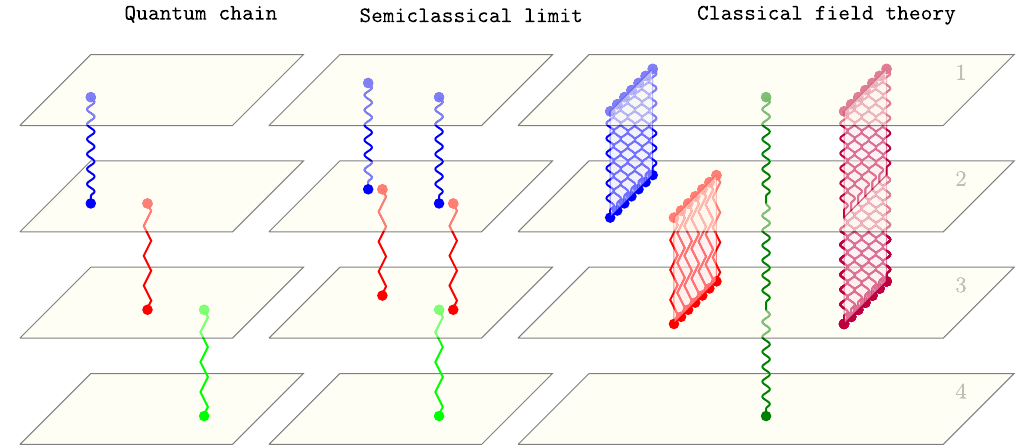
4. Elementary and auxiliary excitations in the fundamental SU(4) quantum spin chain with on-site representation ð 4 Þ , represented on the associated four-sheeted Riemann surface. Left: physical momentum-carrying magnons (blue) emanating from the upper sheet, and two flavors of auxiliary magnons (red and green). Middle: semiclassical limit, depicting quantized stack excitations with nearly coinciding rapidities. Right: four-sheeted Riemann surface encoding the classical spectral curve of an effective low-energy field theory, with two types of excitations — isolated stacks, representing various branches of linear Goldstone modes, and condensates of stacks (square-root branch cuts) pertaining to nonlinear interacting modes carrying a finite amount of energy. Physical stacks (dark green) and condensates (blue and purple) involve momentum-carrying excitations. Condensates of stacks of a uniform density are identified with classical